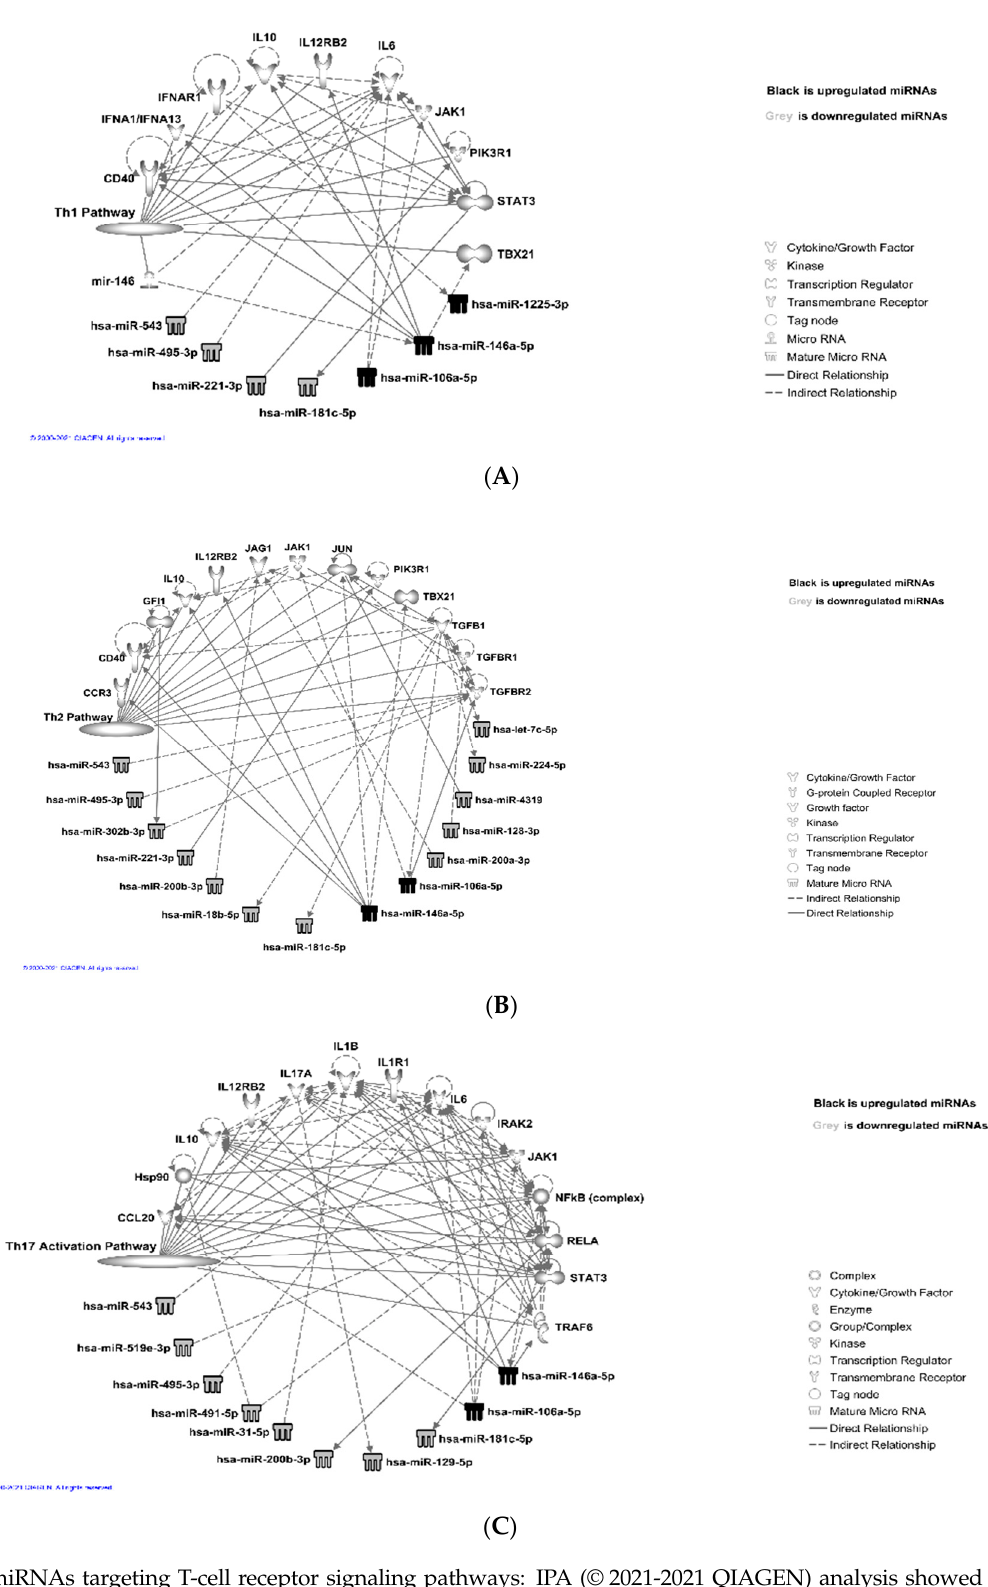
Figure 5. miRNAs targeting T-cell receptor signaling pathways: IPA (© 2021-2021 QIAGEN) analysis showed that these miRNAs target T-cell receptor signaling (both Th1 and Th2) and Th17 activation pathways: ( A ) T-helper 1 (Th1); ( B ) T-helper 2 (Th2); ( C ) T-helper 17 (Th17) activation pathway.